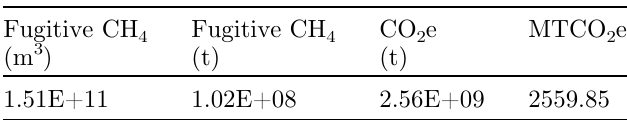
Table 2. Well completion emission (MTCO fi eld.